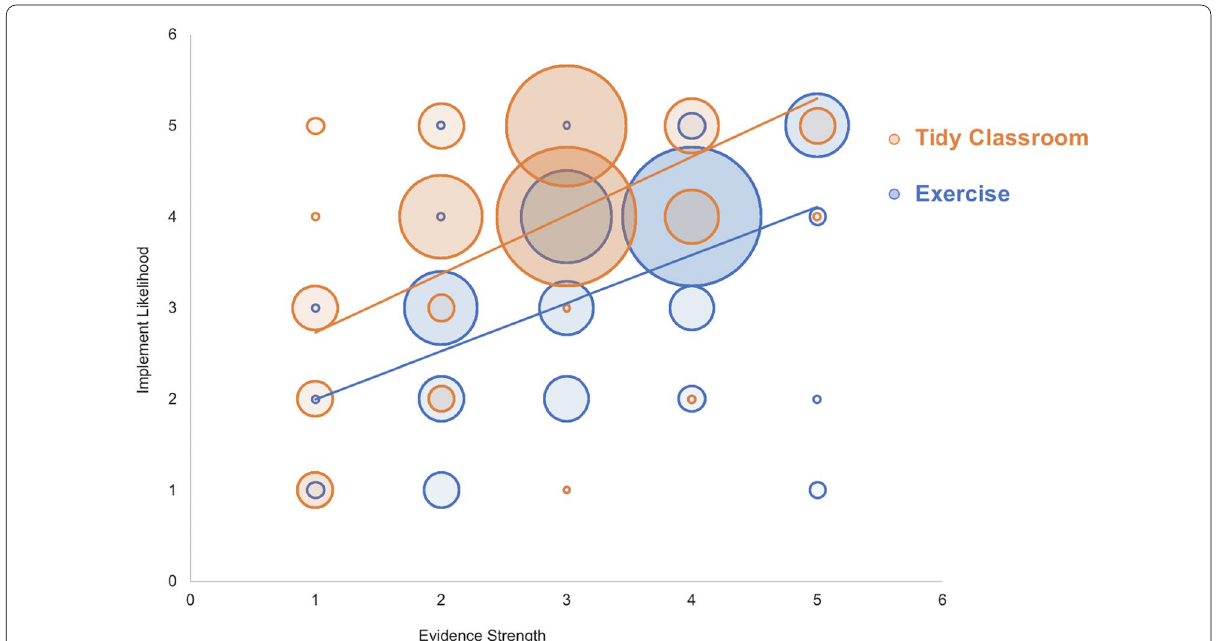
Fig. 2 Correlations between ratings of evidence strength (x-axis) and likelihood of implementing the intervention (y-axis) for the exercise (blue) and tidy classroom (orange) interventions. The width of the bubbles represents the number of participants for each data